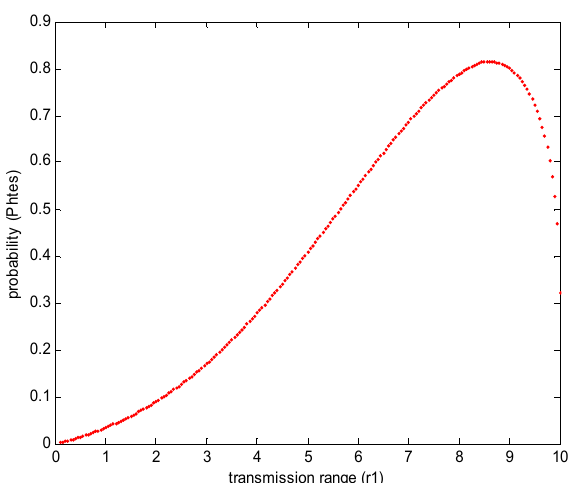
Figure 25. The probability under different transmission range in heterogeneous networks.